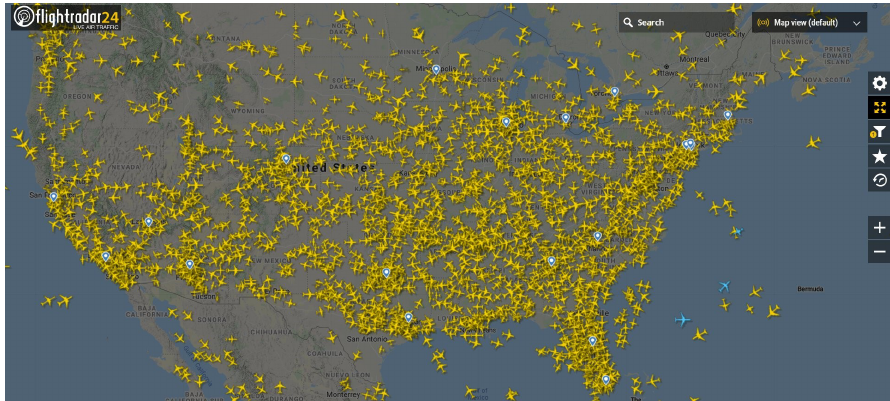
Figure 3. Commercial flight traffic above the US post COVID-19 outbreak showing a 30 percent reduction, 29 March 2020